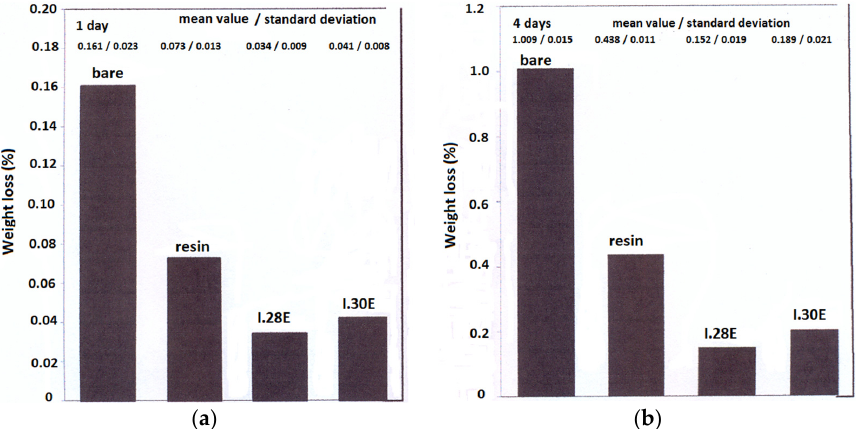
Figure 6. Weight loss results from salt spray experiments for bare steel and steel coated with pristine epoxy resin, and nanocomposites with I.28 and I.30 organo-clays, after 1 day ( a ) and 4 days ( b ) of exposure in a corrosive environment of 100% saturated moisture + 5 wt % NaCl